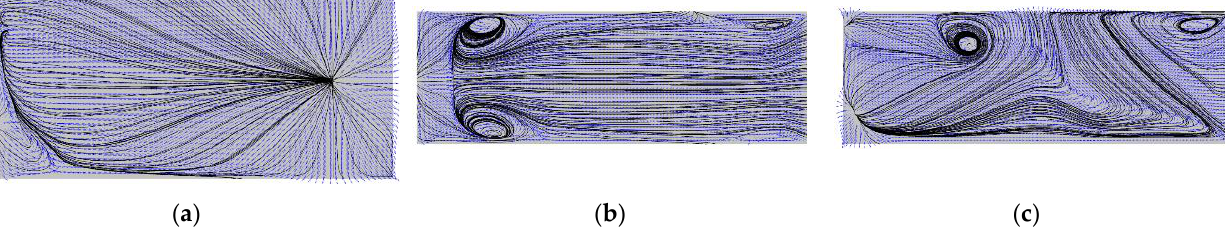
Figure 17. Streamline near the rear wall and sidewalls. ( a ) Rear wall region. ( b ) Left wall region. ( c ) Right wall region.